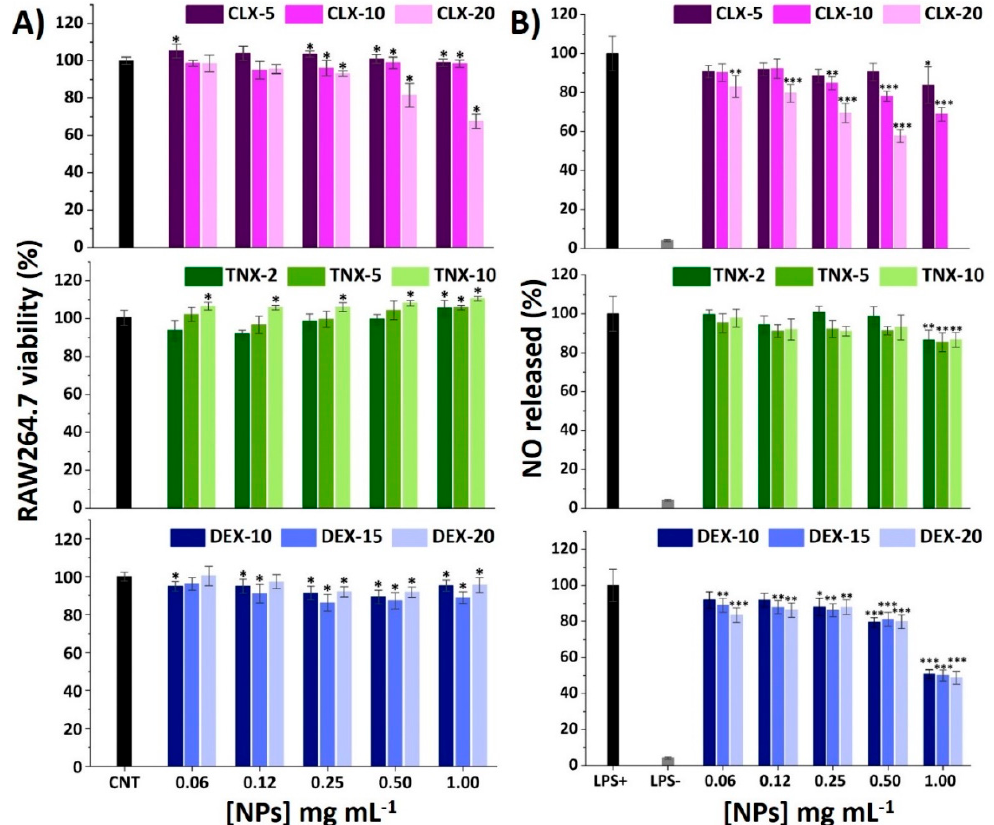
Figure 3. ( A ) Effect of CLX, TNX and DEX NPs on RAW264.7 viability after 24 h. Mean ± SD values are relative to control cells without NP treatment (CNT), in which cell viability was taken as 100%. ANOVA of the results was performed with respect to CNT at a significance level of * p < 0.05. ( B ) Effect of CLX, TNX and DEX NPs on NO production in LPS-stimulated cells. Mean ± SD values are relative to control LPS+, in which NO production was taken as 100%. CLX-20 NPs at a concentration of 1.00 mg mL − 1 were not tested since they showed cytotoxic effects on the AlamarBlue ® viability test. ANOVA of the results was performed with respect to LPS+ at significance levels of * p < 0.05, ** p < 0.005 and *** p <